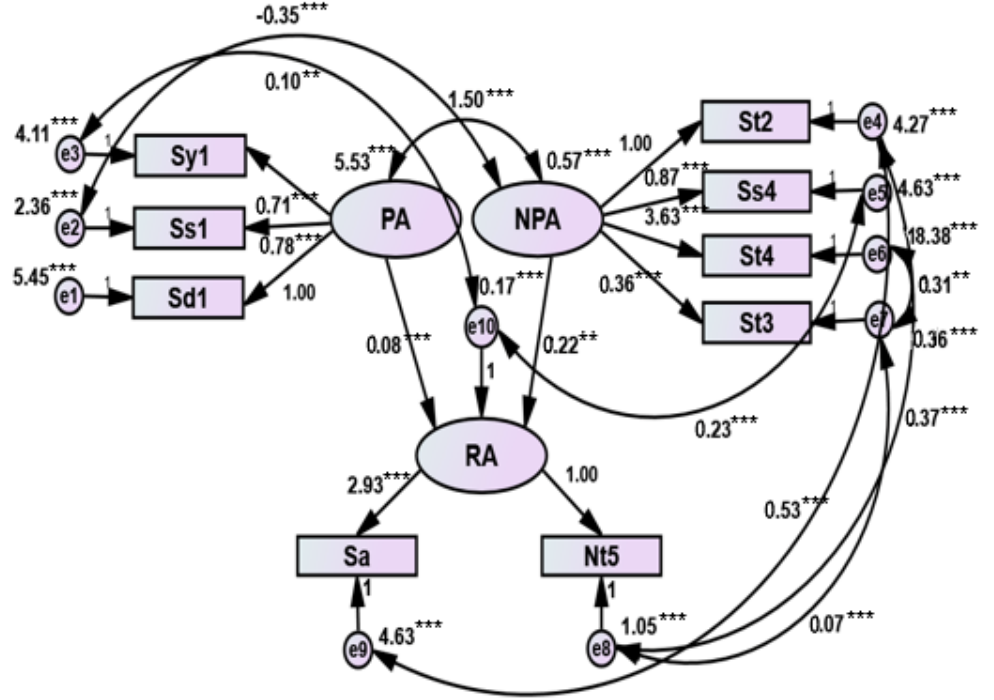
Figure 4. Cognitive skills and reading structural equation models (Note: ** p < 0.01. *** p < 0.001, two-tailed).